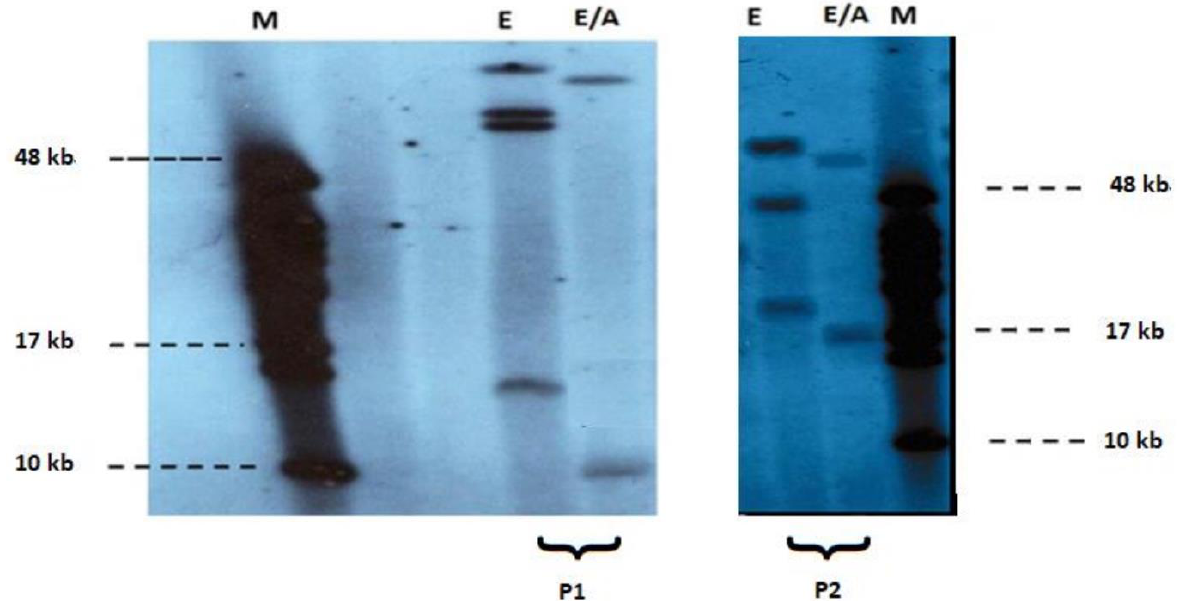
Figure 2. Pulsed-field gel electrophoresis-based FSHD diagnosis of EcoRI (1) and EcoRI/AvrII (2) digested DNA and subsequent non-radioactive Southern blot analysis using p13E-11 probe in patients P1, P2. Clinical diagnosis of FSHD was confirmed by the detection of short EcoRI/AvrII (E/A) fragments (~9 kb and 17 kb respectively) M: 48 kb marker (Biolabs).